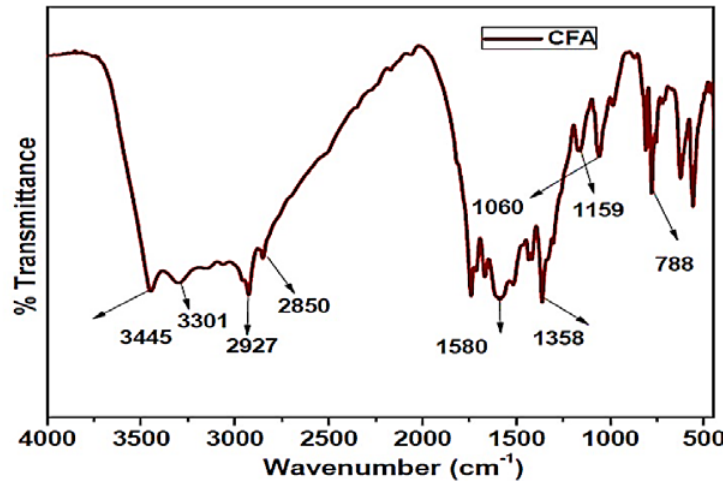
Figure 3. FTIR curve of CFA.